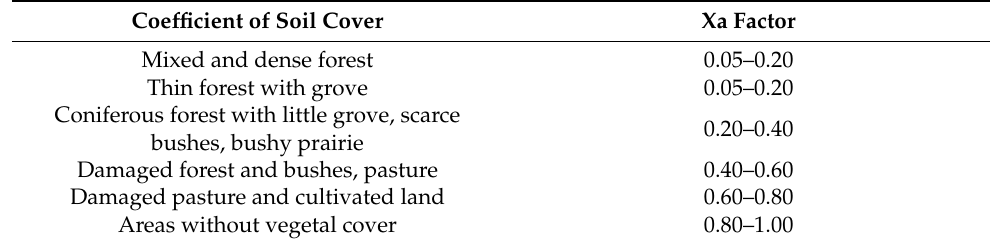
Table 3. EPM Soil protection coefficient